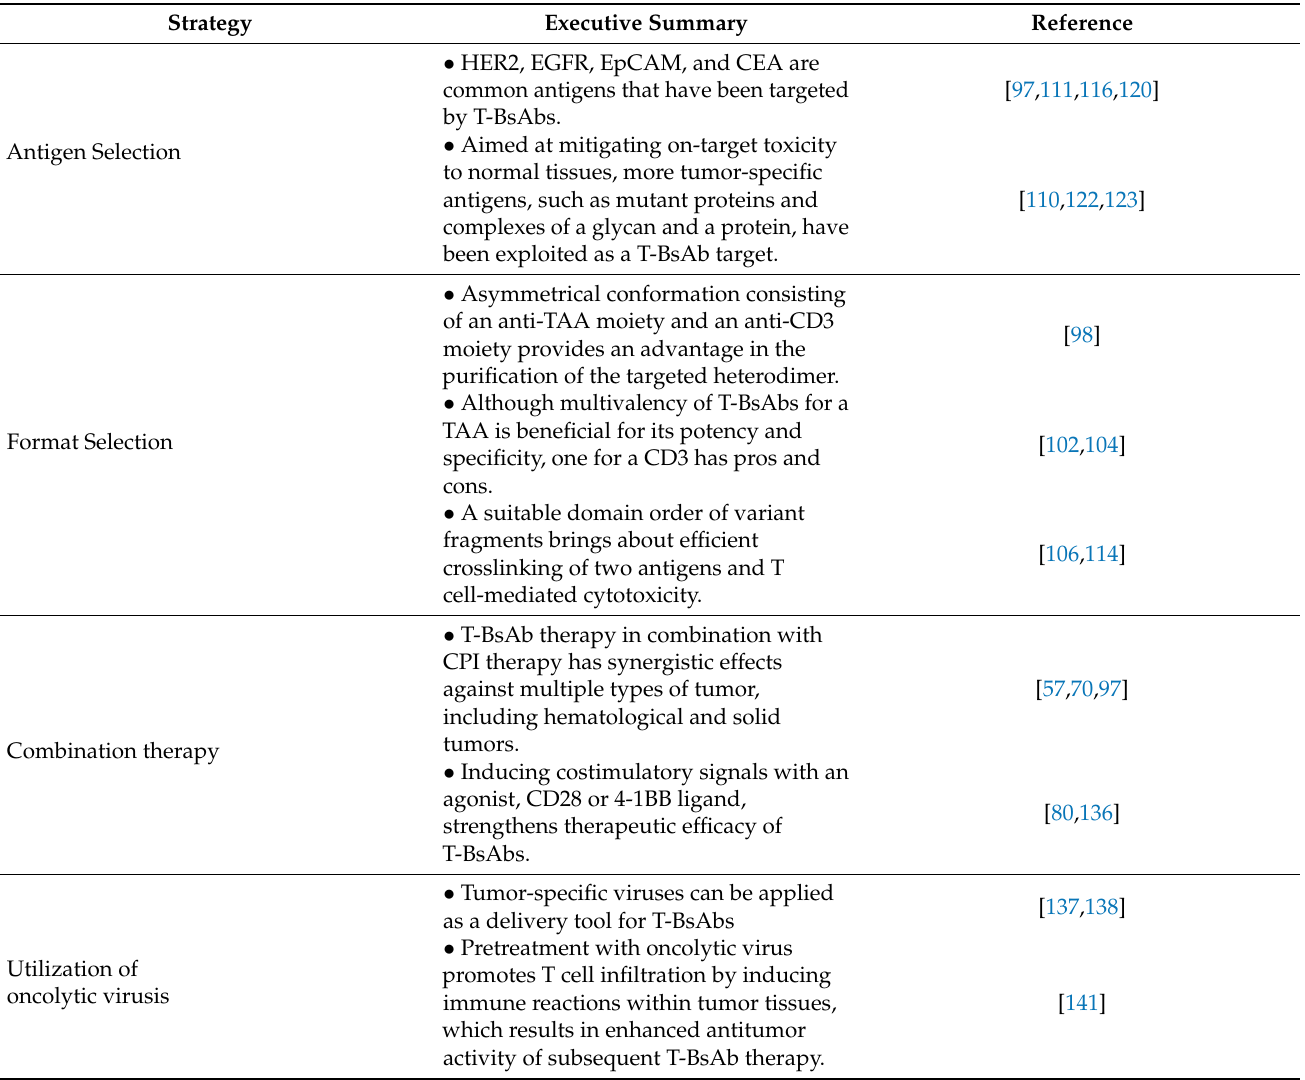
Table 1. The current T-BsAb strategies in preclinical